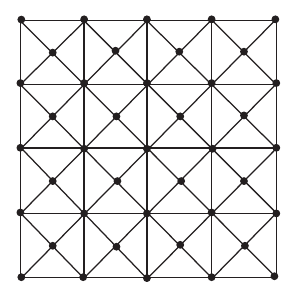
Figure 1: Enhanced mesh M ( 5 , 5 ) Table 1: EM ( m, n ) edge partition centred on the degree of the ending vertices of each edge, where uv ∈ E ( G ) .